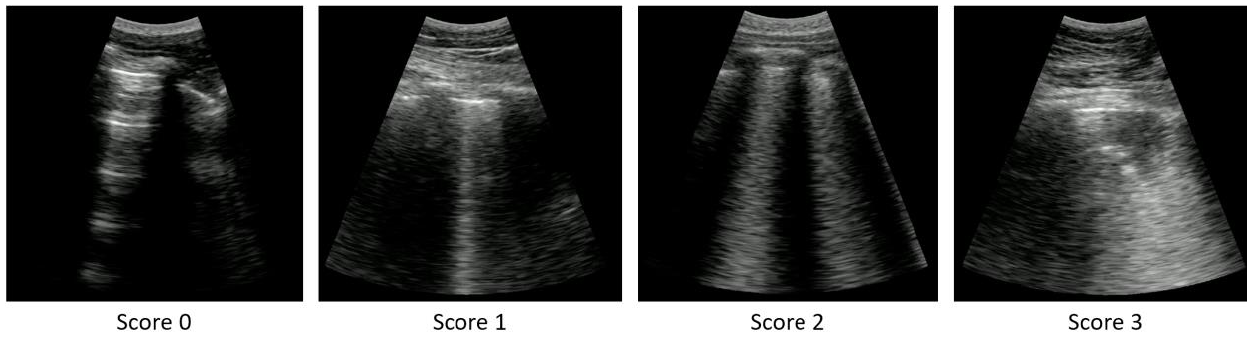
Figure 2. Examples of the four different scores for the respective LUS findings.